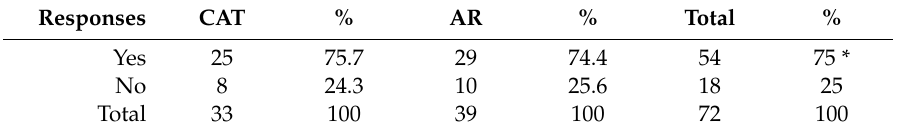
Table 3. Answers obtained in Q1 (Source: Authors).